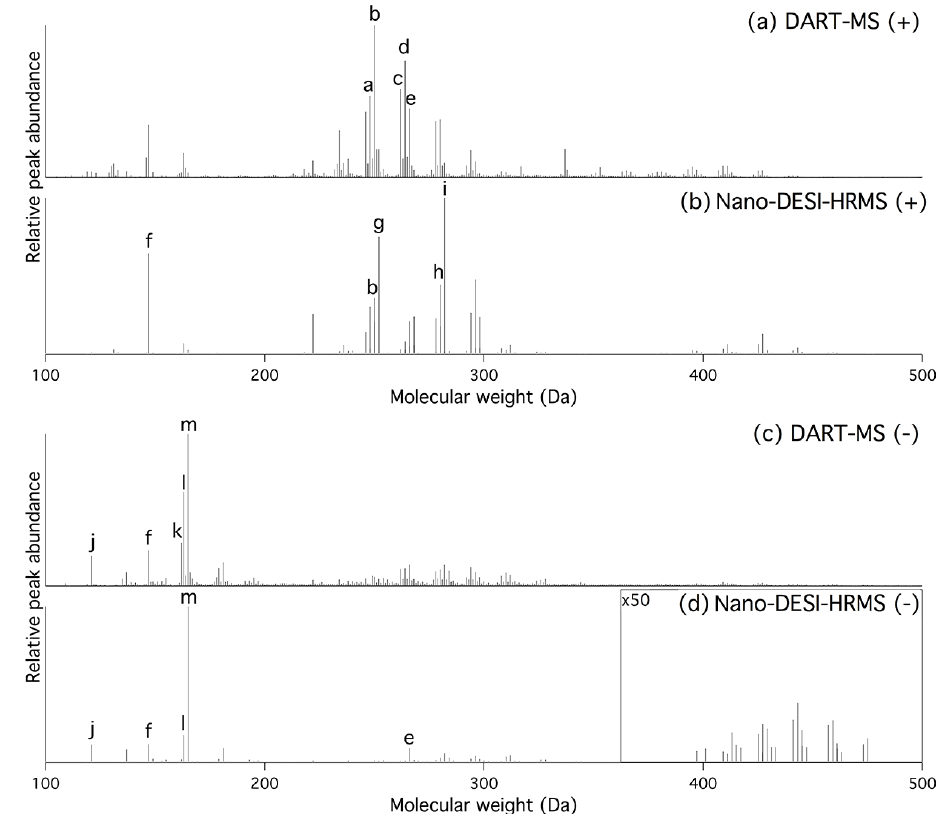
Figure 5. Nano-DESI and DART mass spectra of indole SOA plotted as a function of the molecular weights of the neutral compounds. The nano-DESI mass spectra contain only peaks assignable to specific formulas, while DART mass spectra contain all observed peaks. The five most abundant peaks in each mass spectrum are indicated with letters: (a) 248Da, C 15 H 8 O 2 N 2 ; (b) 250Da, C 15 H 10 O 2 N 2 , tryptan- thrin; (c) 262Da, C 16 H 10 O 2 N 2 , indirubin and/or indigo dye; (d) 264Da, C 16 H 12 O 2 N 2 , dihydro indigo dye; (e) 266Da, C 15 H 10 O 3 N 2 ; (f) 147Da, C 8 H 5 O 2 N, isatin; (g) 252Da, C 15 H 12 O 2 N 2 ; (h) 280Da, C 16 H 12 O 3 N 2 ; (i) 282Da, C 16 H 14 O 3 N 2 ; (j) 121Da, C 7 H 7 ON,